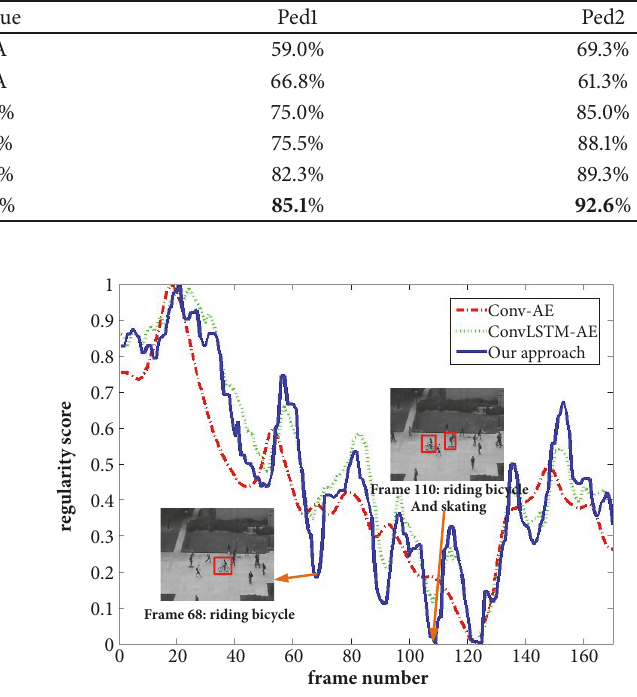
Figure 7: Regularity scores of different approaches in the 8th video clip of Avenue